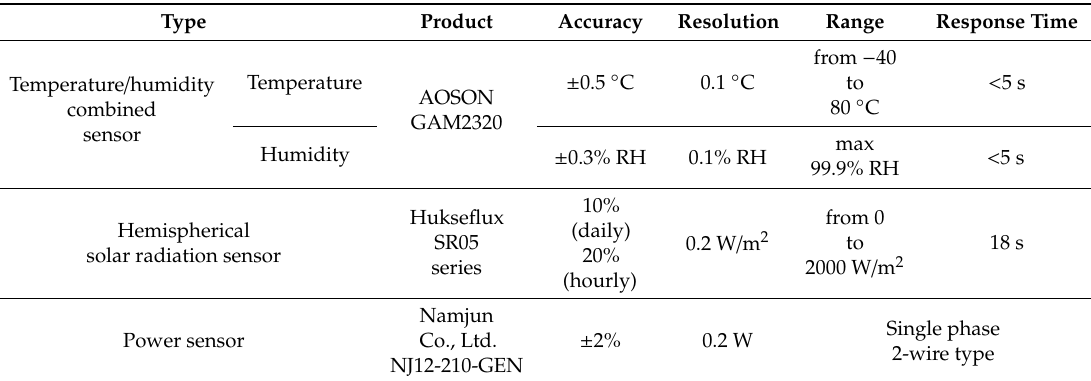
Table 2. Specifications of measuring instruments.